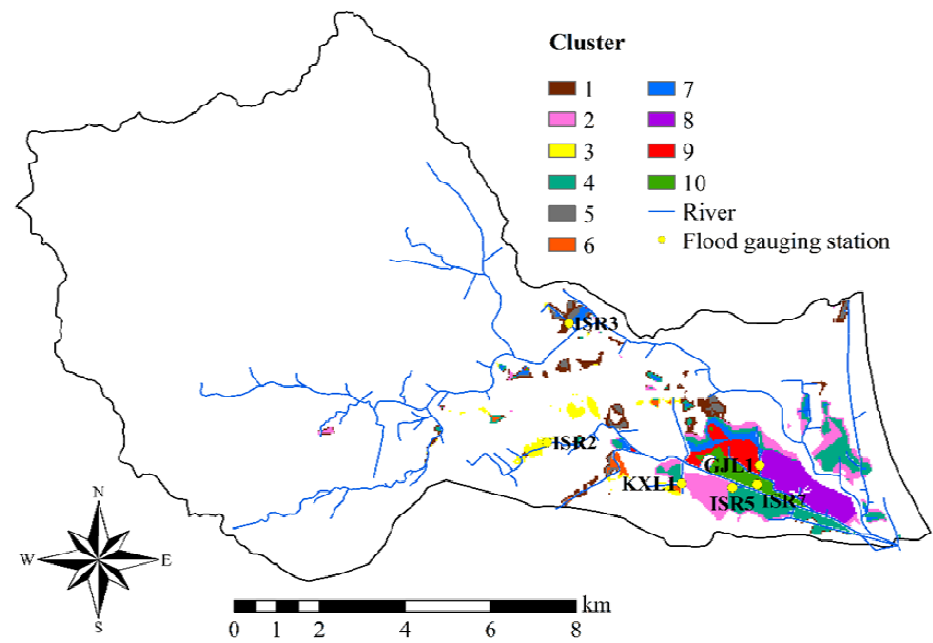
Figure 7. Data clustering results from the k- means clustering algorithm, along with locations of flood gauging stations.